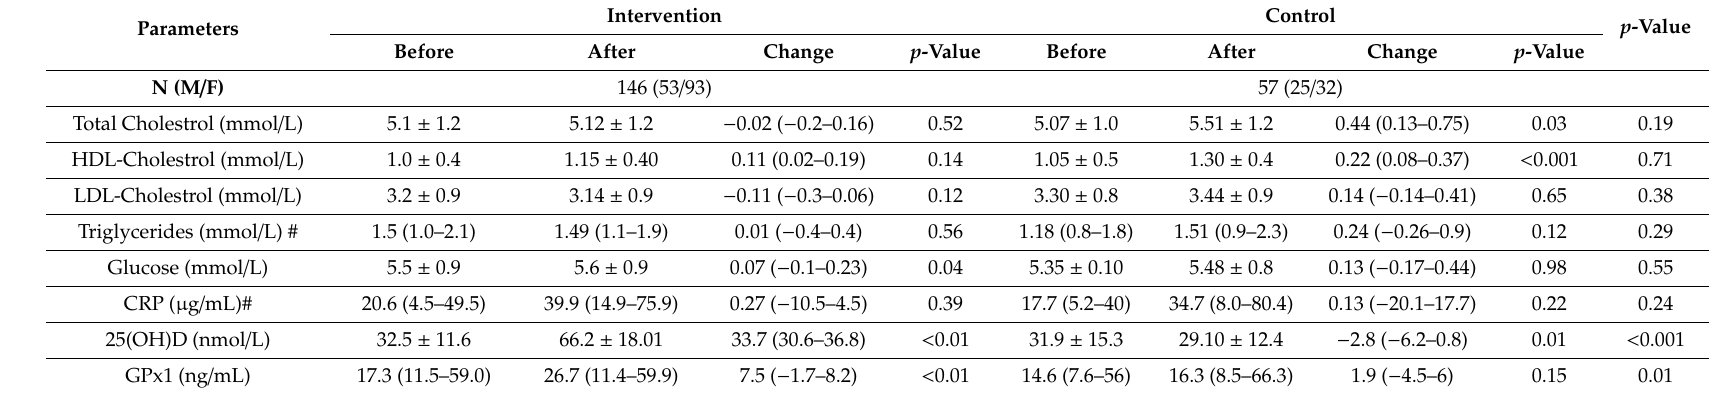
Table 1. Clinical Characteristics of Groups Before and After 6 Months of Intervention.